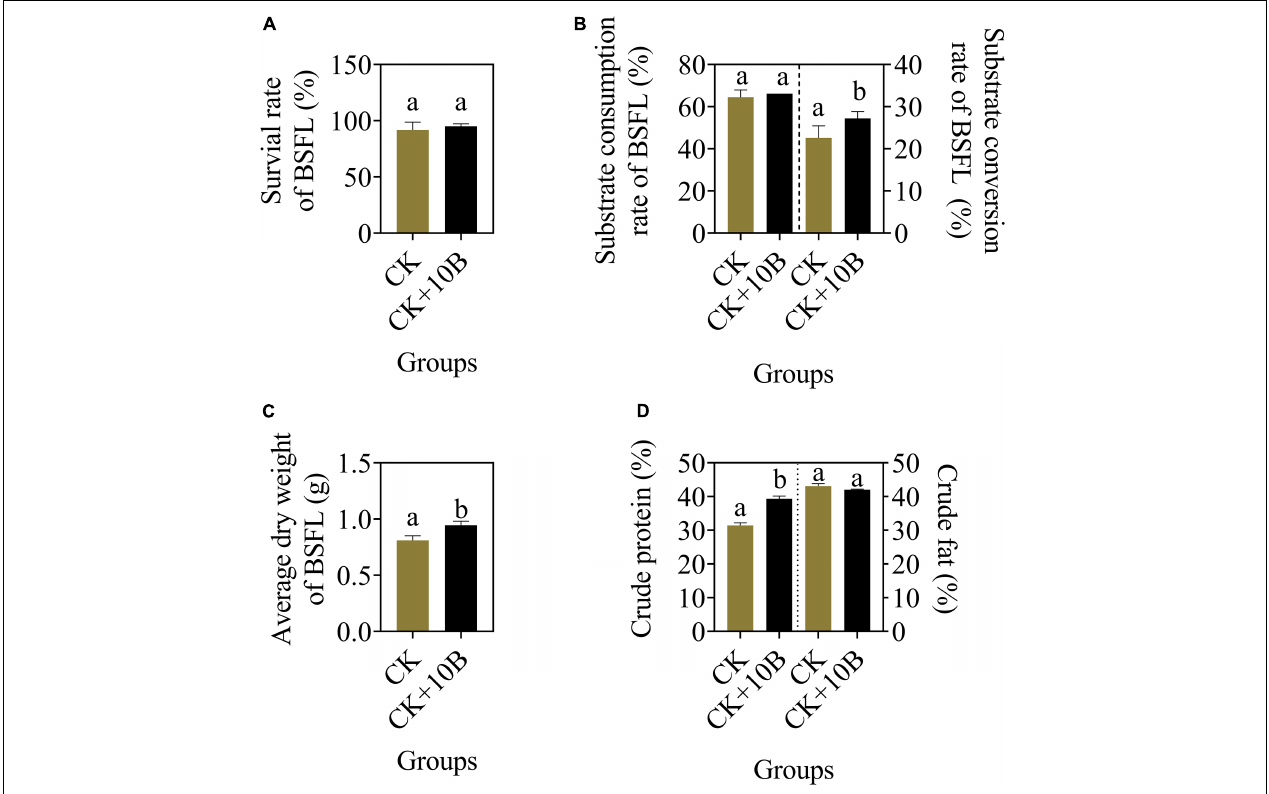
FIGURE 1 | The bio-physiological parameters (A) survival rate, (B) substrate consumption/conversion rate, (C) average dry weight, and (D) crude protein/fat content of BSFL in the CK and CK + 10B groups. CK, natural BSFL fed on non-sterile food waste; CK + 10B, natural BSFL fed on non-sterile food waste and 10B. Data are presented as mean ± standard deviation ( n = 3). Values with different letters mean significant differences at p < 0.05, as determined by Tukey’s test.